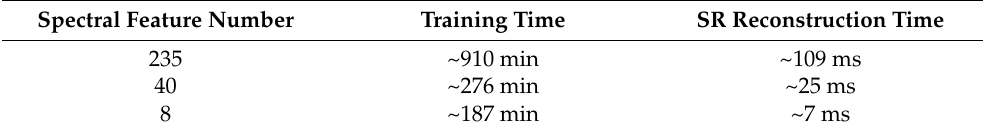
Table 4. Comparison of training time (20 epochs) and SR reconstruction